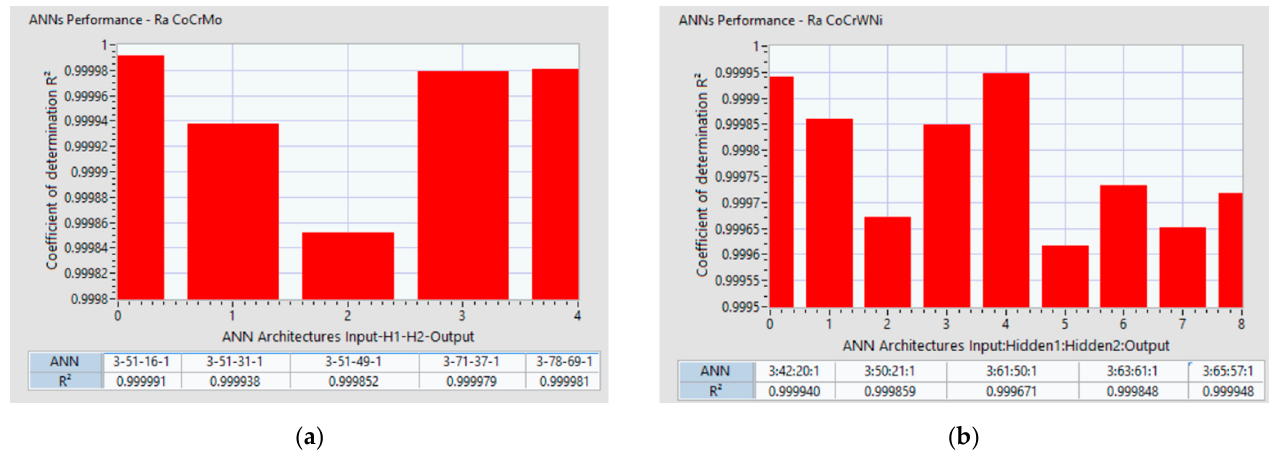
Figure 16. Coefficient of determination variation with ANN layers: ( a ) configuration for Co–28Cr–6Mo alloy; ( b ) configuration for Co–20Cr–15W–10Ni.